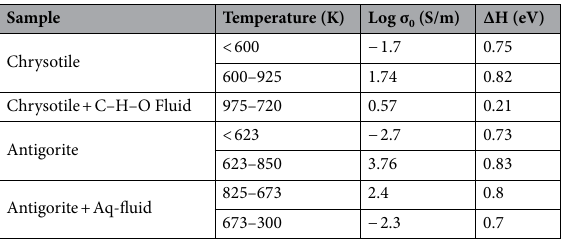
Table 1. Fitting parameters for electrical conductivity of serpentine and dehydrating fluids.